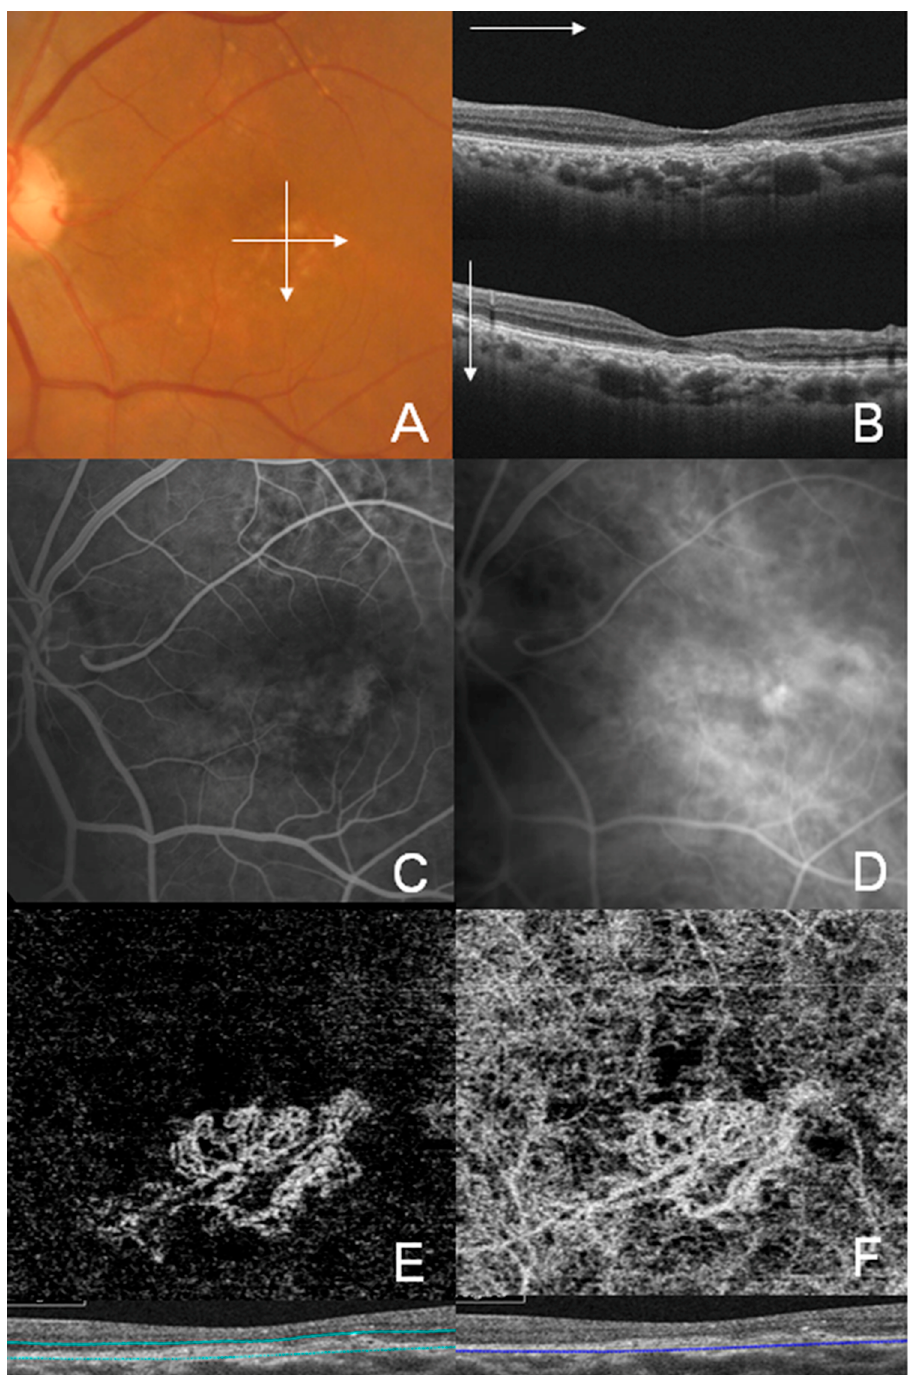
Figure 2. Multimodal imaging of Group A (well-circumscribed) type 1 choroidal neovascularization (CNV) in a 72-year–old male. ( A ) Color fundus photograph; ( B ) Swept-source optical coherence tomography (OCT) B-scan image of the fovea showing shallow vascularized pigment epithelial detachment with choroidal thickening. Double-layer sign with a fibrovascular notch suggesting polypoidal choroidal vasculopathy; ( C ) Early phase fluorescein angiography (FA) showed ill-defined CNV; ( D ) Late-phase FA showed ill-defined vascular leakage; ( E ) OCT angiography (OCTA) image of the outer retinal layer of a hyperflow seafan-like pattern lesion; and ( F ) OCTA images of the choriocapillaris.